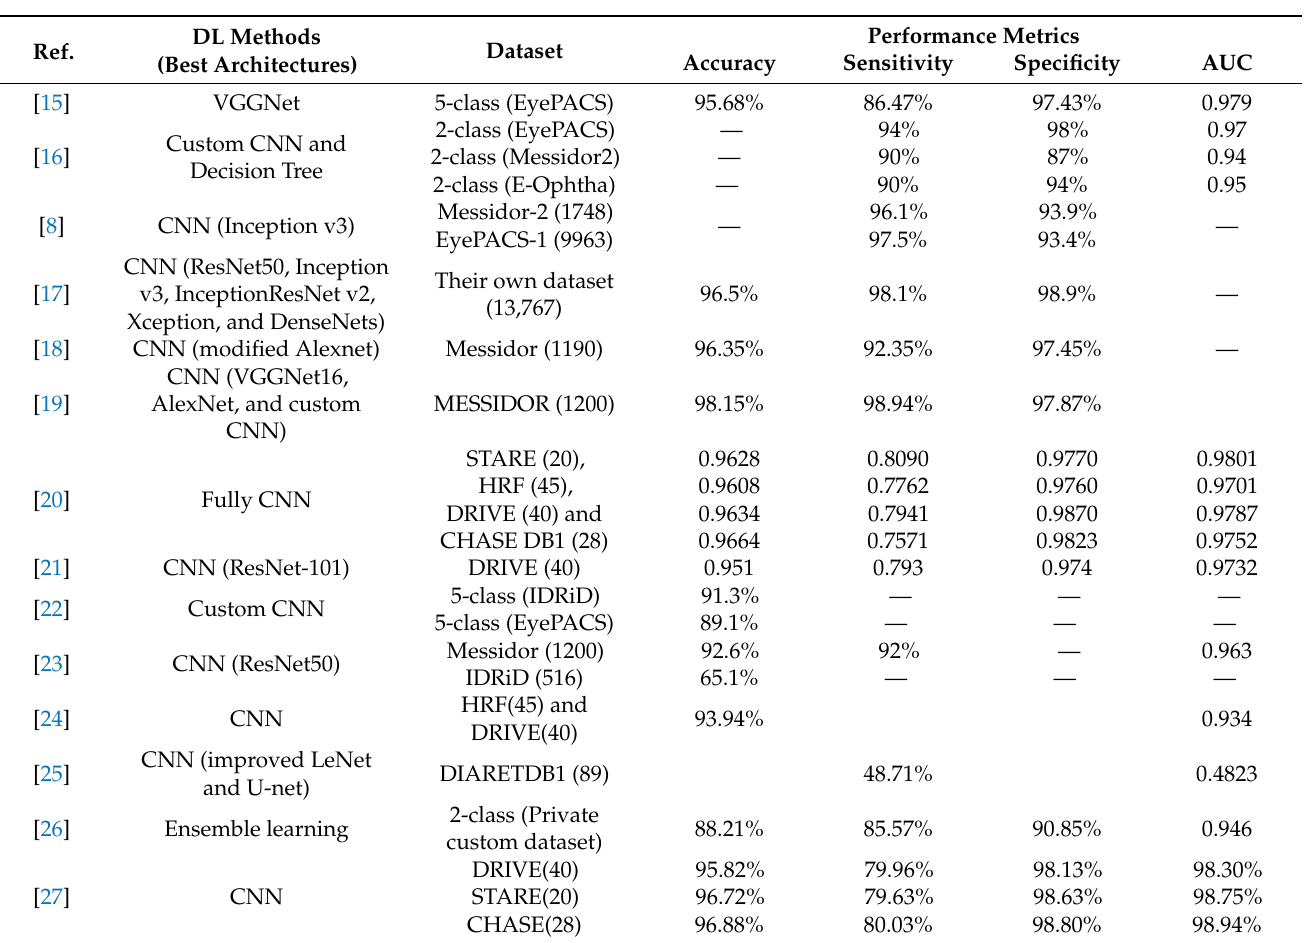
Table 1. Representation of traditional deep learning approaches for DR detection and classification over various